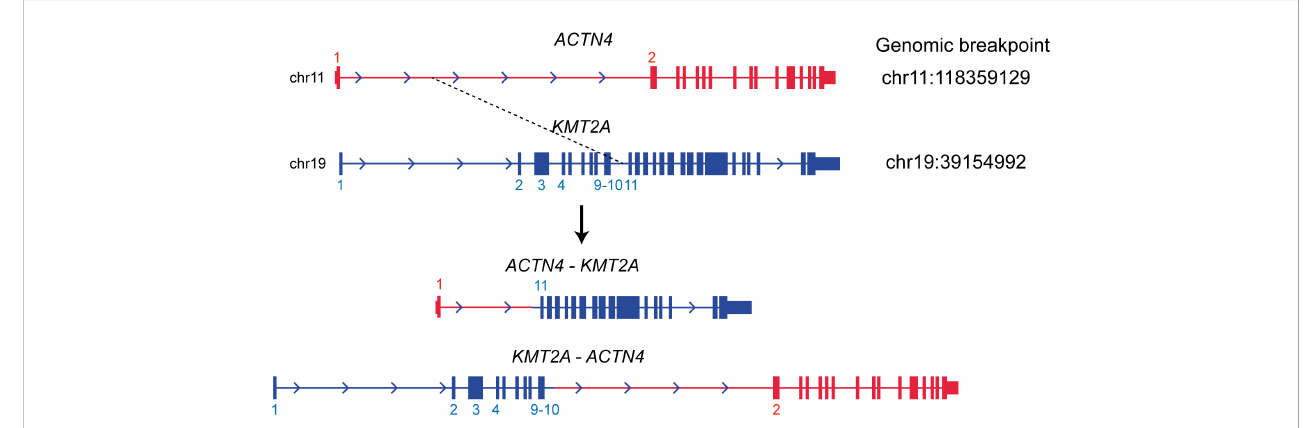
FIGURE 2 Translocation between KMT2A and ACTN4 genes. It was commonly detected in the CMMoL and APLL